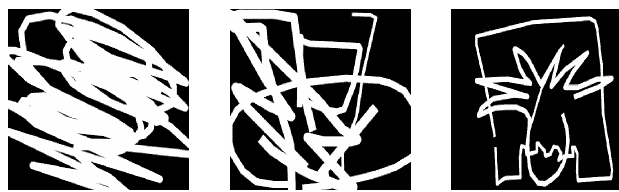
Figure 3. Irregular mask examples of the QD-IMD: Quick Draw Irregular Mask